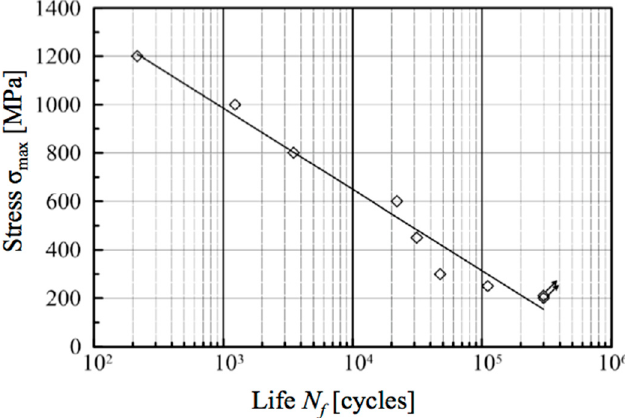
Figure 13. S-N logarithmic plot of one-sided tensile testing for fatigue strength of material 1.2709.